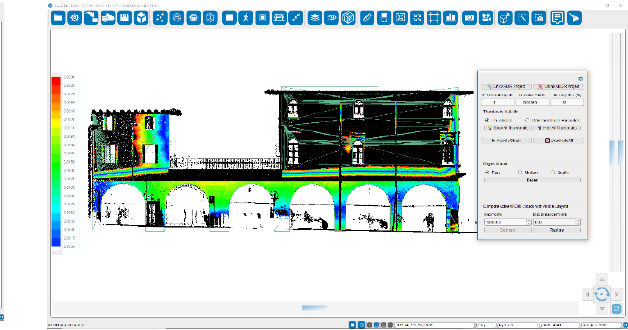
Figure 9. Internal wall: Advanced 3D vs TLS points cloud.